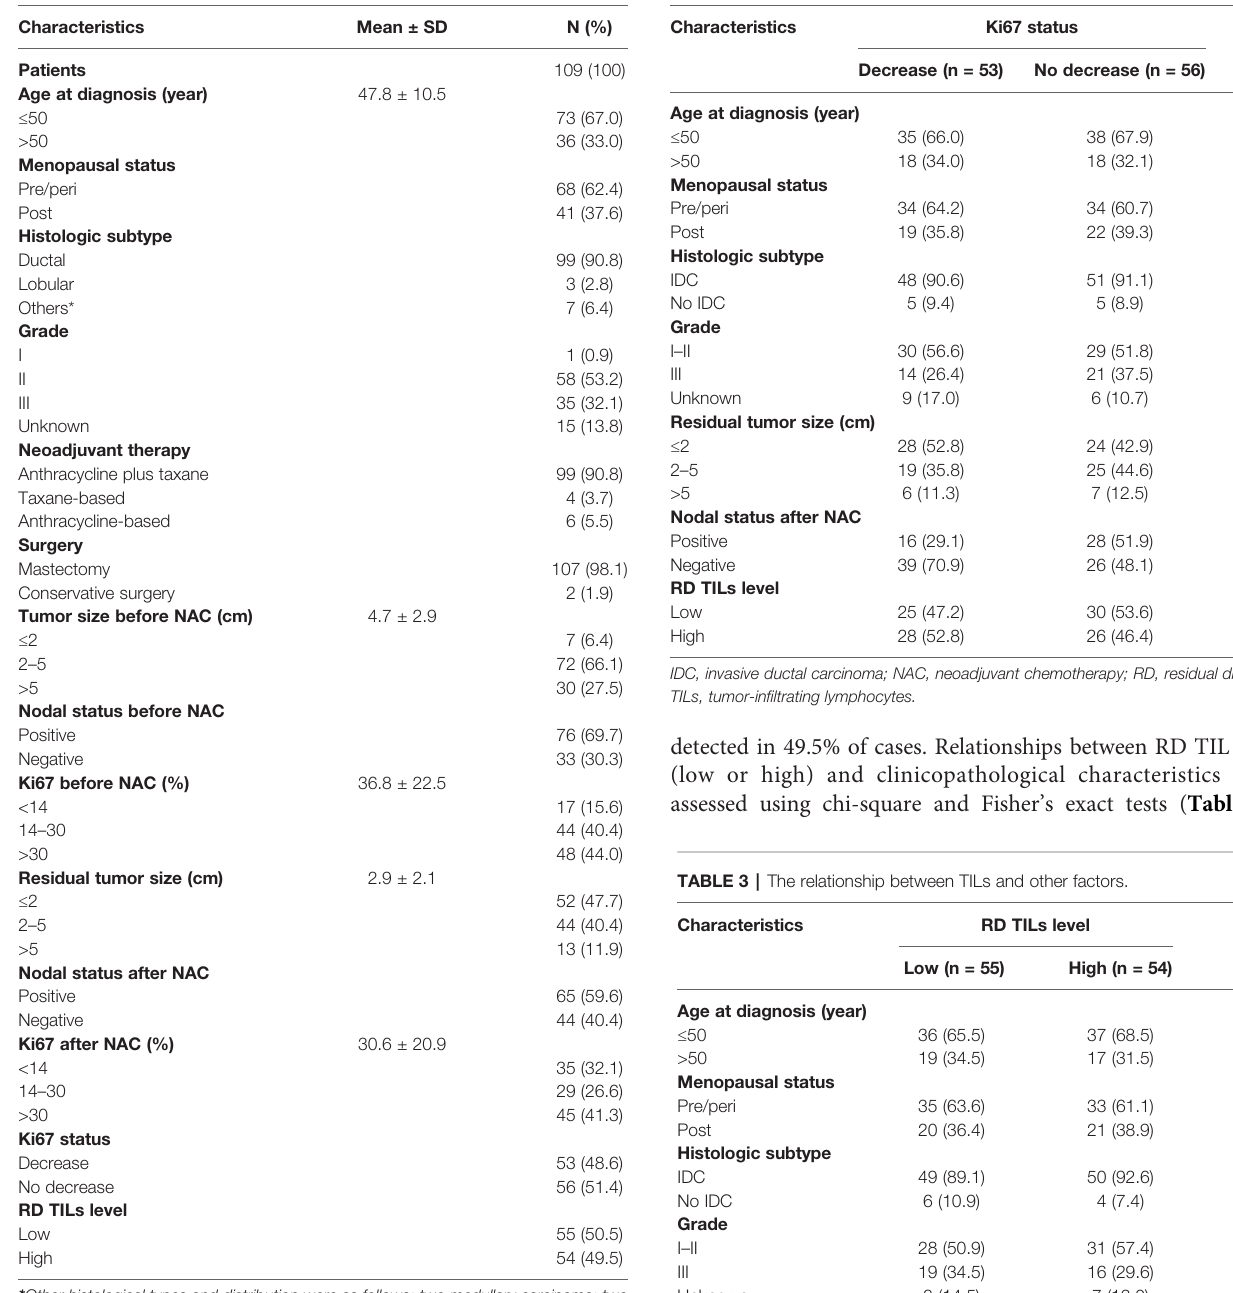
TABLE 1 | Clinicopathological characteristics of patients (n = 109). TABLE 2 | The relationship between Ki67 status and other factors.